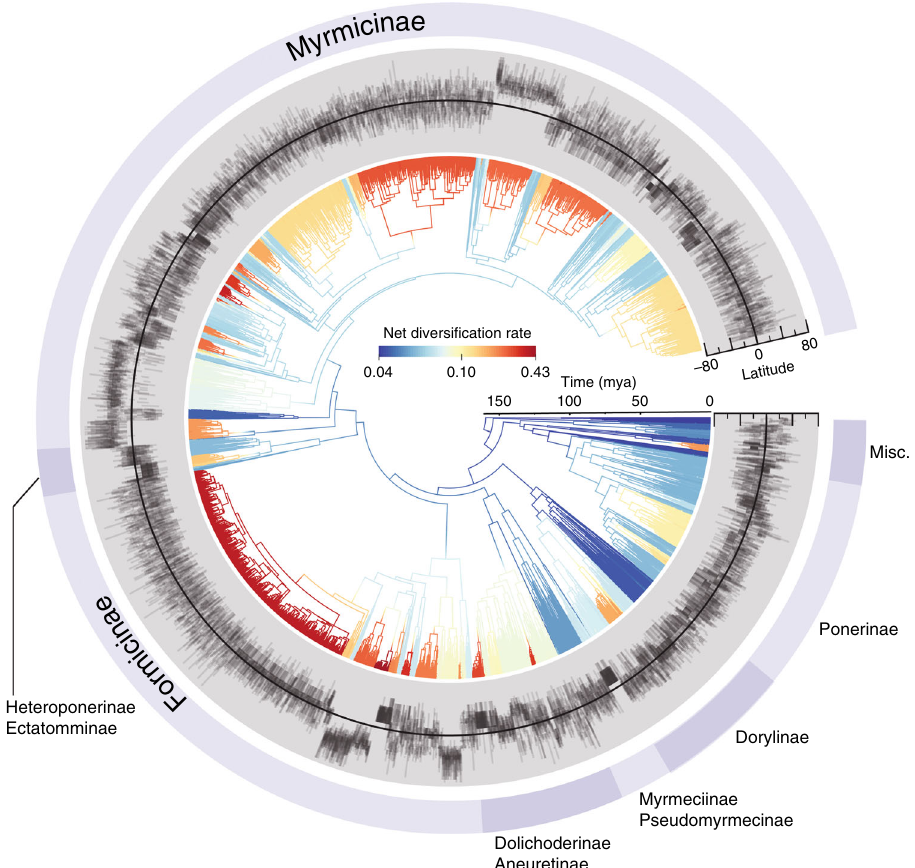
Fig. 1 Phylogenetic position and latitudinal extent of 14,512 ant species. The all-ant ML phylogeny dated using median node ages across the posterior tree set from a Bayesian dating analysis, annotated with the latitudinal ranges of each species. Branches are colored by net diversi fi cation rate inferred by BAMM 62 . The displayed tree was constructed using median node ages under the NC-stem dating/grafting method and was used to give typical results for visualization purposes, but the analyses were performed individually on 100 separate trees from the posterior for each